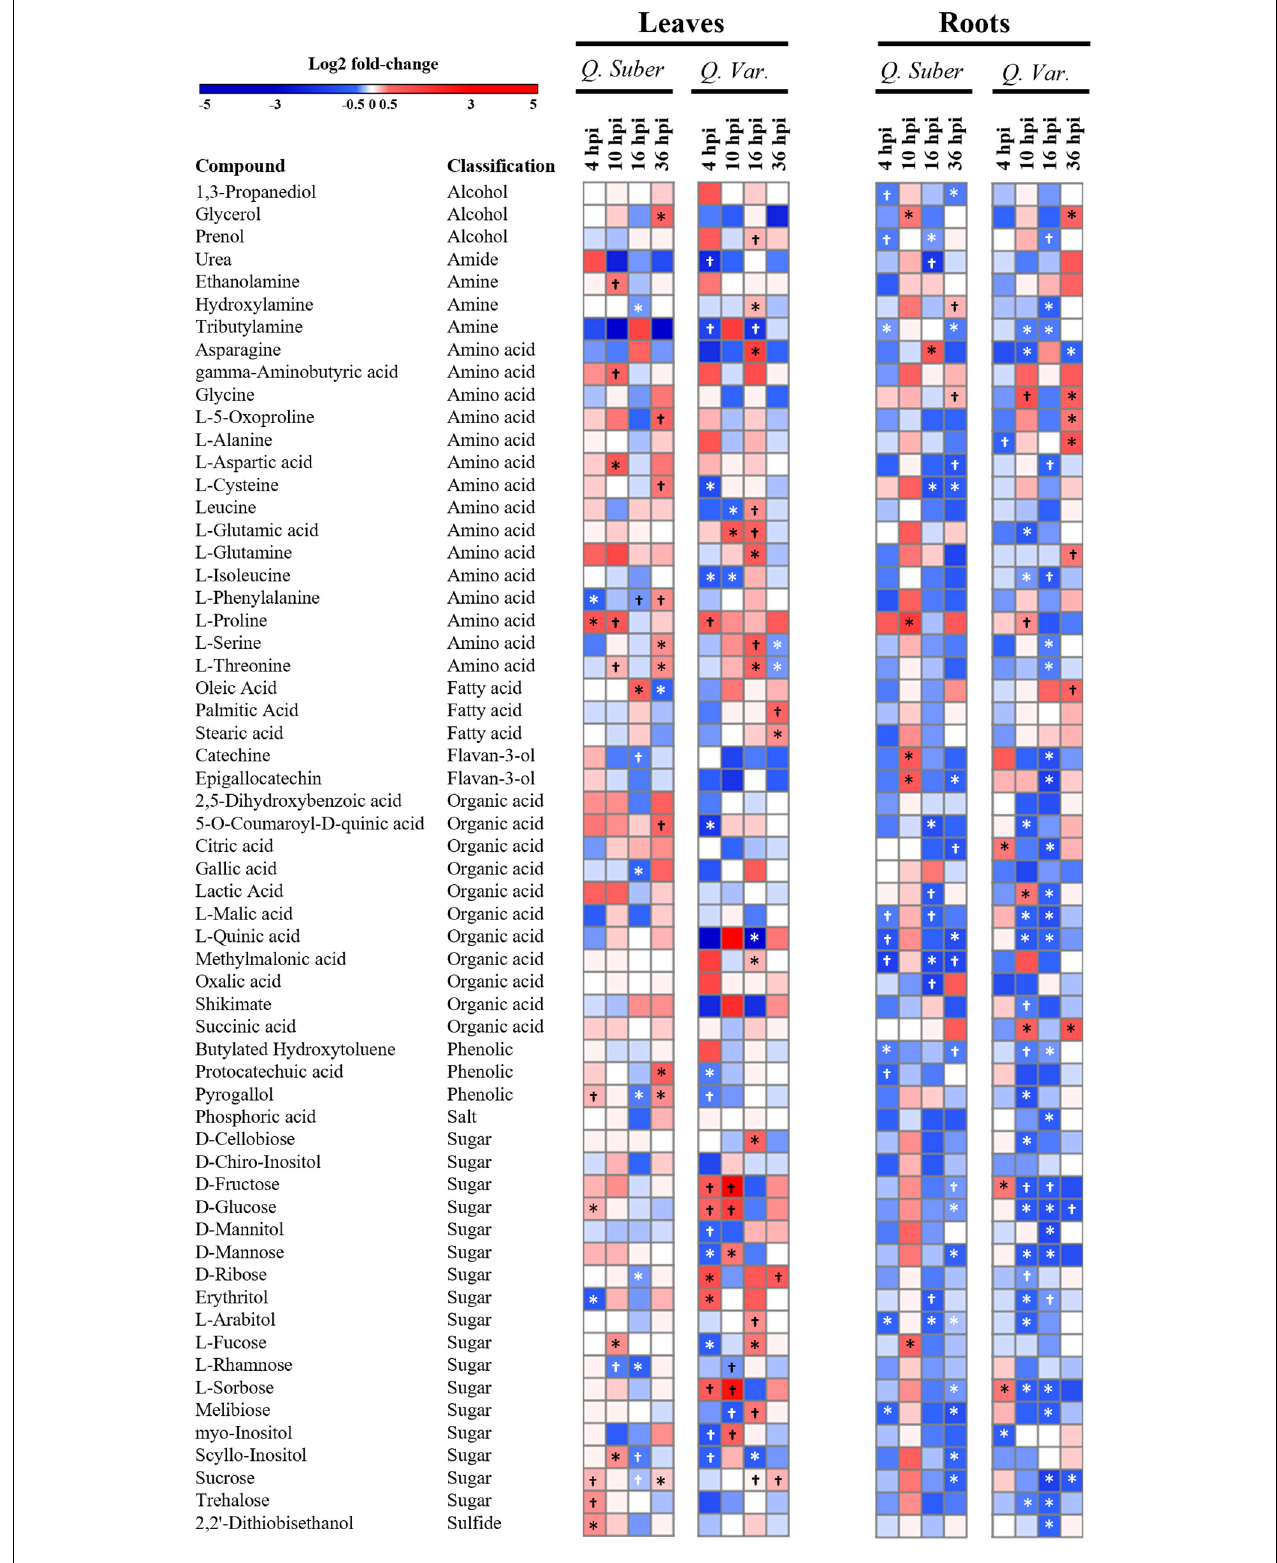
FIGURE 9 | Heatmap showing log 2-fold changes in metabolites isolated from Q. suber and Q. variabilis leaves and roots after P. cinnamomi inoculation. Symbols indicate statistically significant differences according to Student’s t -test ( † p < 0.1 and ∗ p < 0.05).